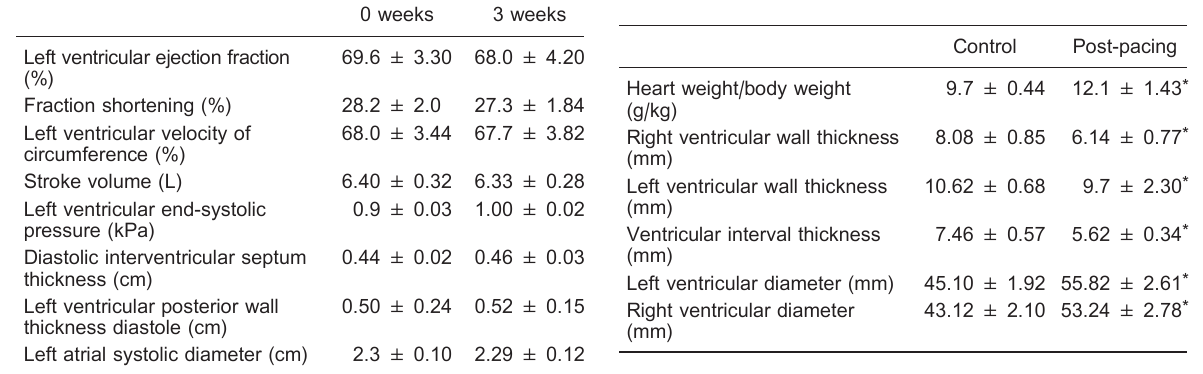
Table 2. Hemodynamic parameters in the control group at baseline and after 3 weeks. Table 3. Heart mass and dimensions in control and pacing